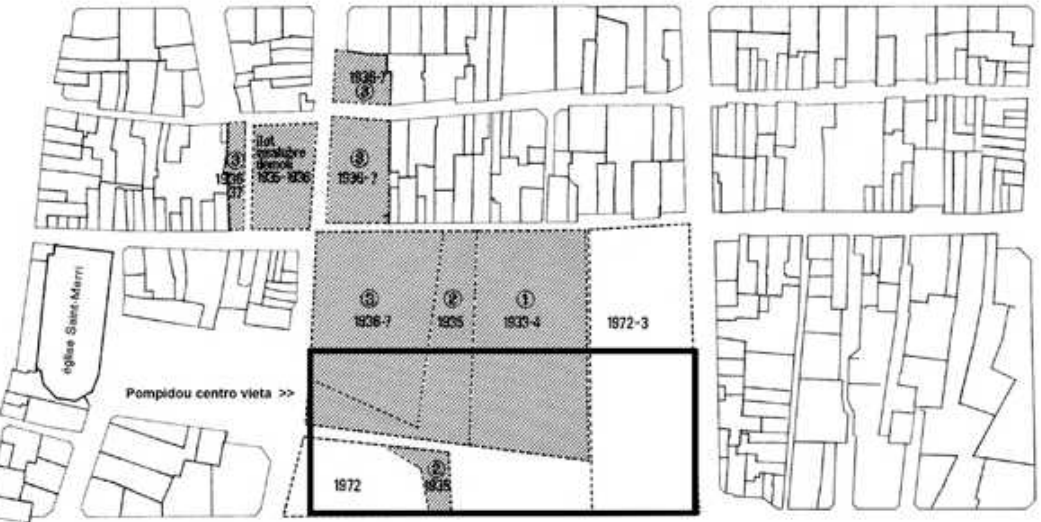
Fig. 1. Paris: the place of Pompidou Centre and explosion of